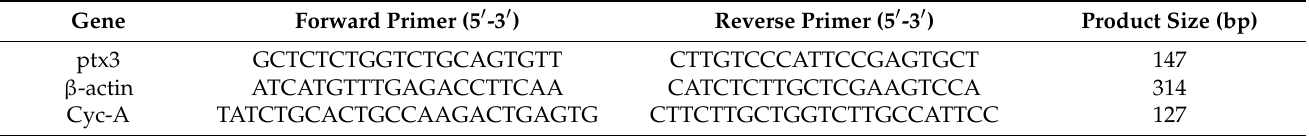
Table 1. Primers sets for real-time- and